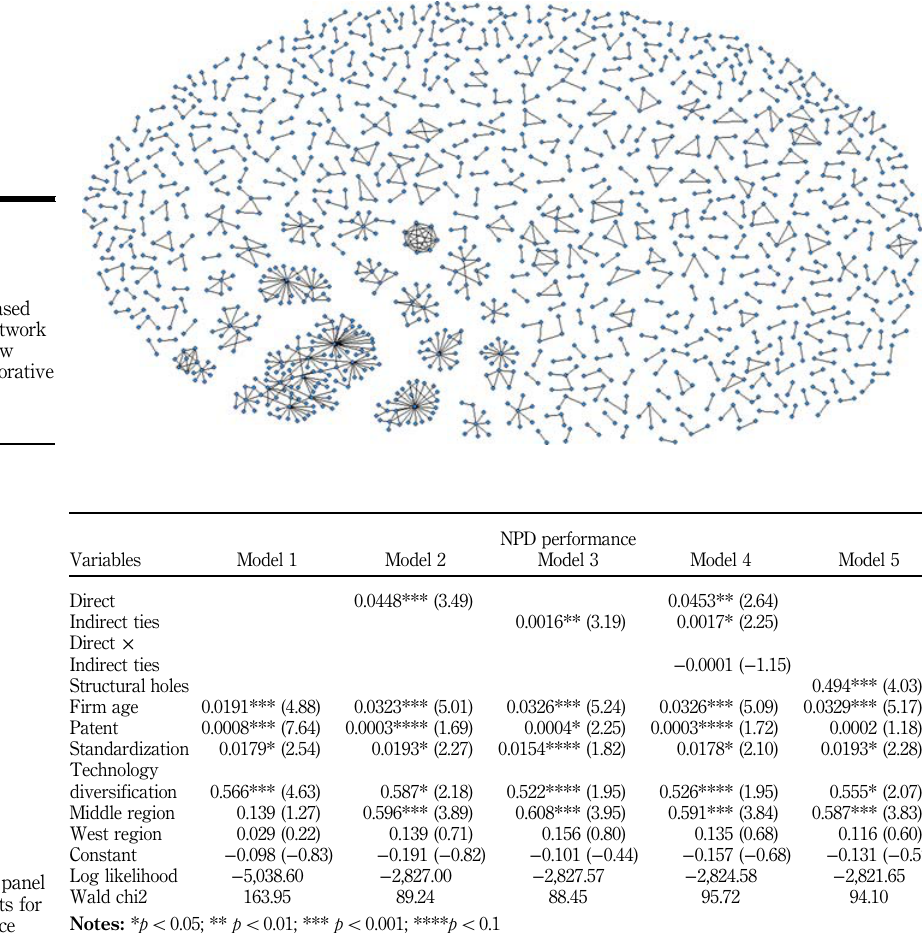
Table II. Random effects panel regression results for NPD performance